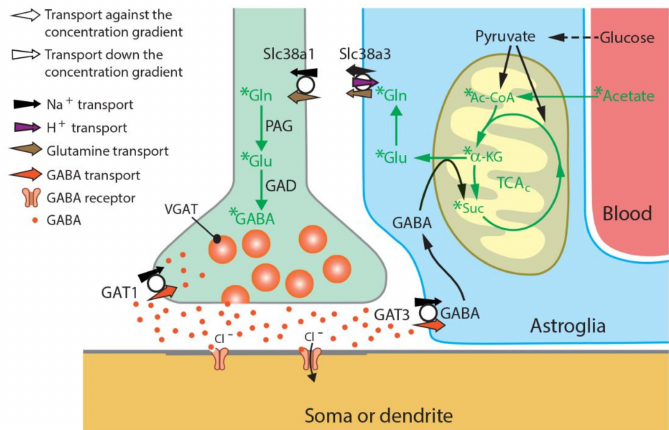
Figure 2. Schematic representation of how acetate contributes to glutamine and GABA synthesis at GABAergic synapses in normal physiological conditions. Radiolabeled acetate, injected intraperitoneally, approaches brain tissue by blood flow and is selectively metabolized in astroglial cells to form glutamine. Our findings (Figure 1) on labeled glutamine, glutamate and GABA together with their relative ratios in Slc38a1 +/+ mice suggest that glutamine formed in astroglia is shuttled to the GABAergic neurons by the glutamine transporters Slc38a3 and Slc38a5 (also known as (aka) SN1 and SNAT3, and SN2 and SNAT5, respectively) and Slc38a1 (aka SAT1, SA2 and SNAT1) at astroglial and neuronal cell membranes, respectively, and sustains GABA pools. Genetic inactivation of Slc38a1 results in significantly lower levels of radiolabeled GABA, implicating that astroglia-derived glutamine and its transport through Slc38a1 is essential for GABA formation and bolsters the existence of a glutamate / GABA-glutamine (GGG) cycle. TCA C , tricarboxylic acid cycle; Ac-CoA, acetyl coenzyme A; α -KG, α -ketoglutaric acid; Suc, succinate; PAG, phosphate-activated glutaminase; GAD, glutamic acid decarboxylase; GAT1 / 3, GABA transporter 1 / 3; VGAT, vesicular GABA transporter; Gln, glutamine; Glu, glutamate; GABA, γ -aminobutyric